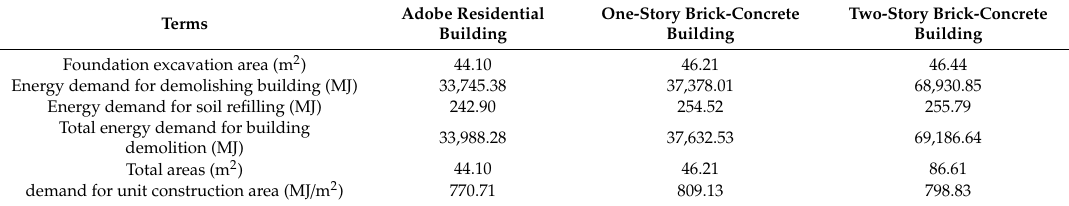
Table 20. Energy demand for building demolition in di ff erent residential buildings (MJ).